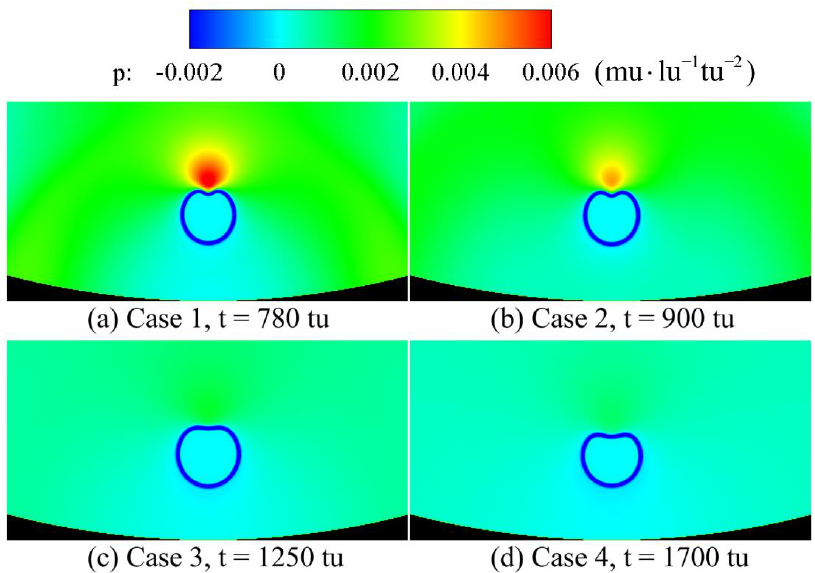
Figure 6. Pressure field of cavitation-bubble collapse for Cases 1–4 (Stage 1). Energies 2020 , 13 , x FOR PEER REVIEW